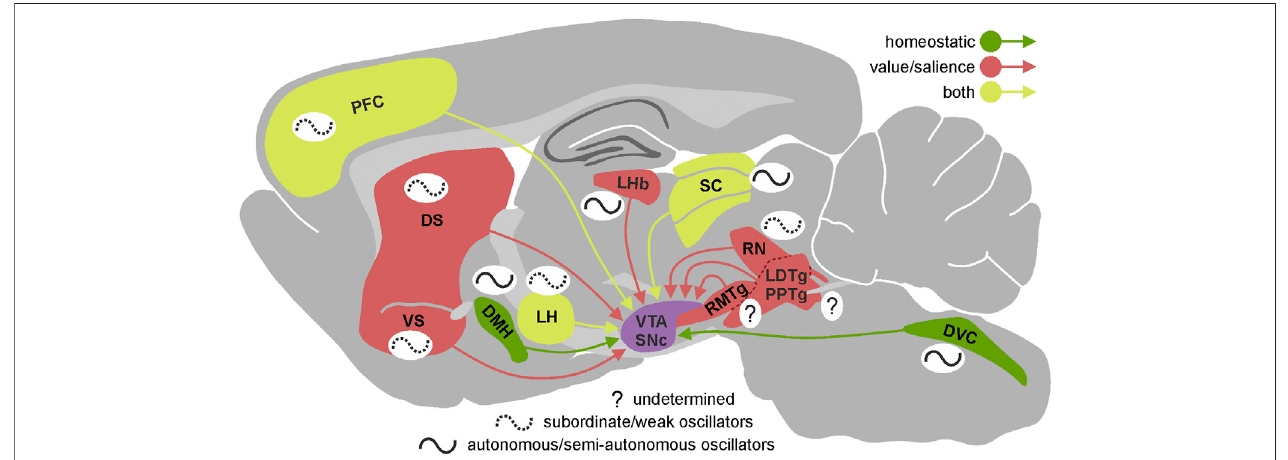
FIGURE1| Circadian properties oftheVTA/SNc inputs.Presenceand autonomy ofcircadianrhythmicity inthe mostimportantbrain regions innervating VTA/SNc presentedonthesagittalsectionofratbrain.Brainregionsaredividedaccordingtothetypeofinformationtheyprovidedopaminergicsystemwith — green:homeostatic, red: value/salience, yellow: both. The schematic wave next to each brain region represents its circadian rhythmicity. Solid line indicates high level of autonomy (autonomous/semi-autonomous oscillator) and dotted line indicates low level of autonomy (subordinate/weak oscillator) while question mark shows that we currently lack the knowledge about circadian properties of a given brain region. VTA, ventral tegmental area; SNc, substantia nigra pars compacta; DS, dorsal striatum; VS, ventral striatum; LHb, lateral habenula; RMTg, rostromedial tegmental nucleus; LDTg, laterodorsal tegmental nucleus; PPTg, pedunculopontine tegmental nucleus; RN, raphe nucleus; SC, superior colliculus; LH, lateral hypothalamus; DMH, dorsomedial hypothalamic nucleus; DVC, dorsal vagal complex; PFC, prefrontal cortex.